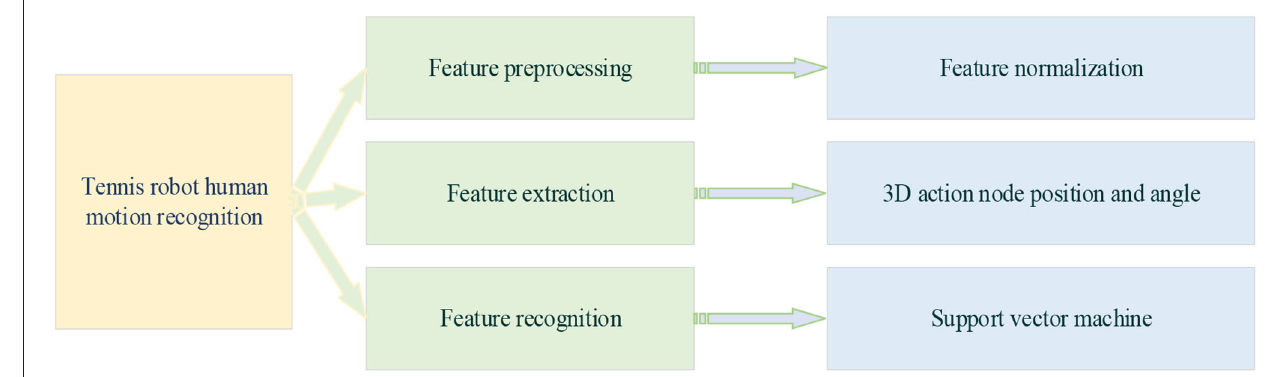
FIGURE 5 | Motion recognition of tennis sports robots.